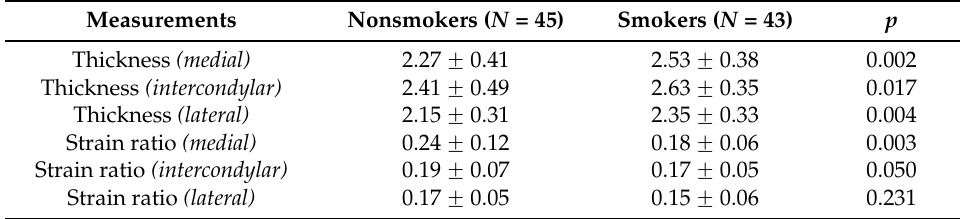
Table 3. Cartilage thickness (mm) and strain ratio measurements (mean ˘ SD).